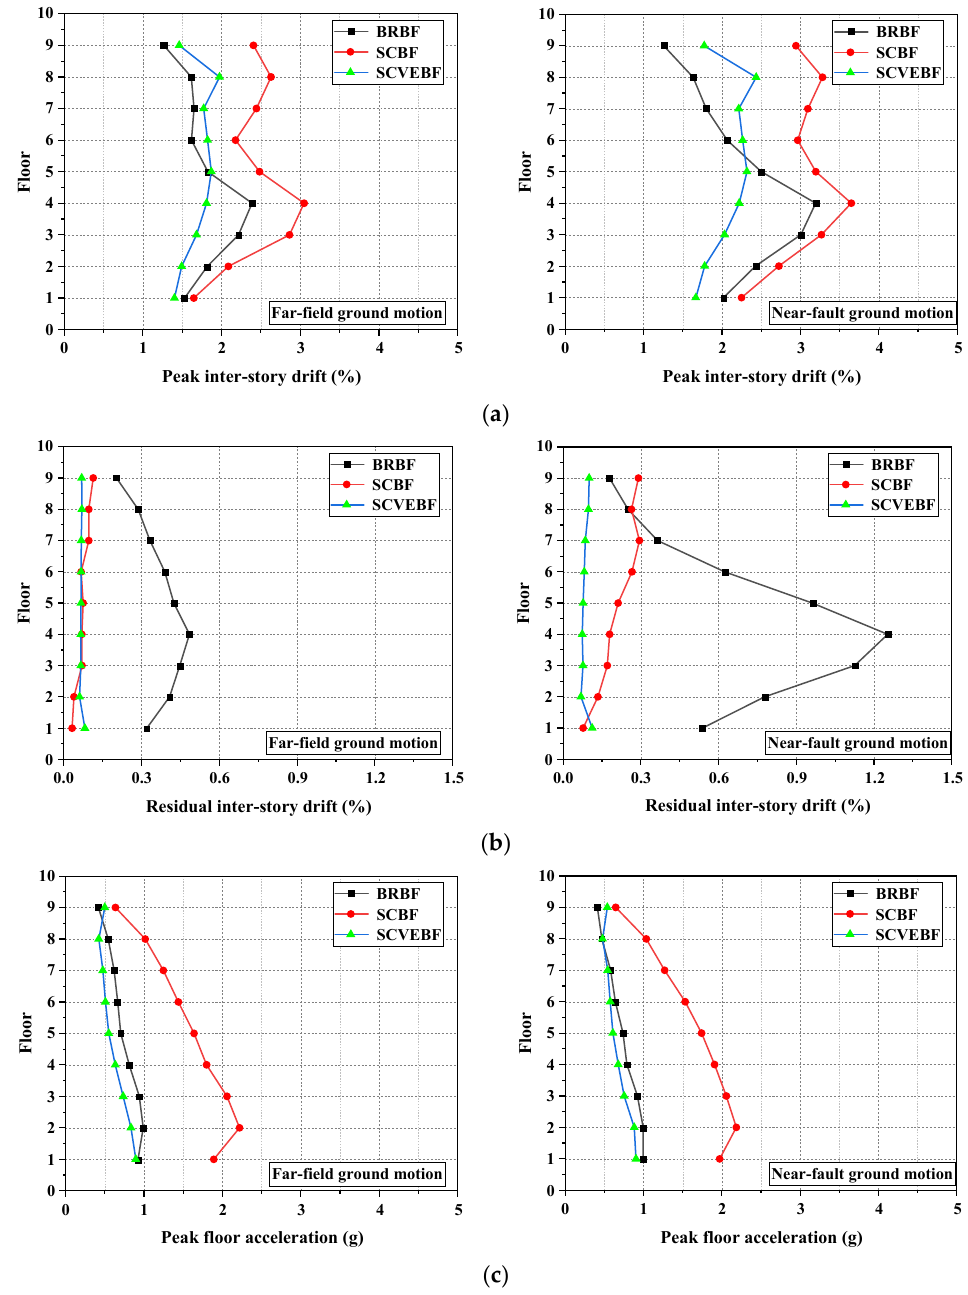
Figure 15. Mean responses of structures: ( a ) peak inter-story drift (PID), ( b ) residual inter-story drift (RID), and ( c ) peak absolute floor acceleration (PFA).